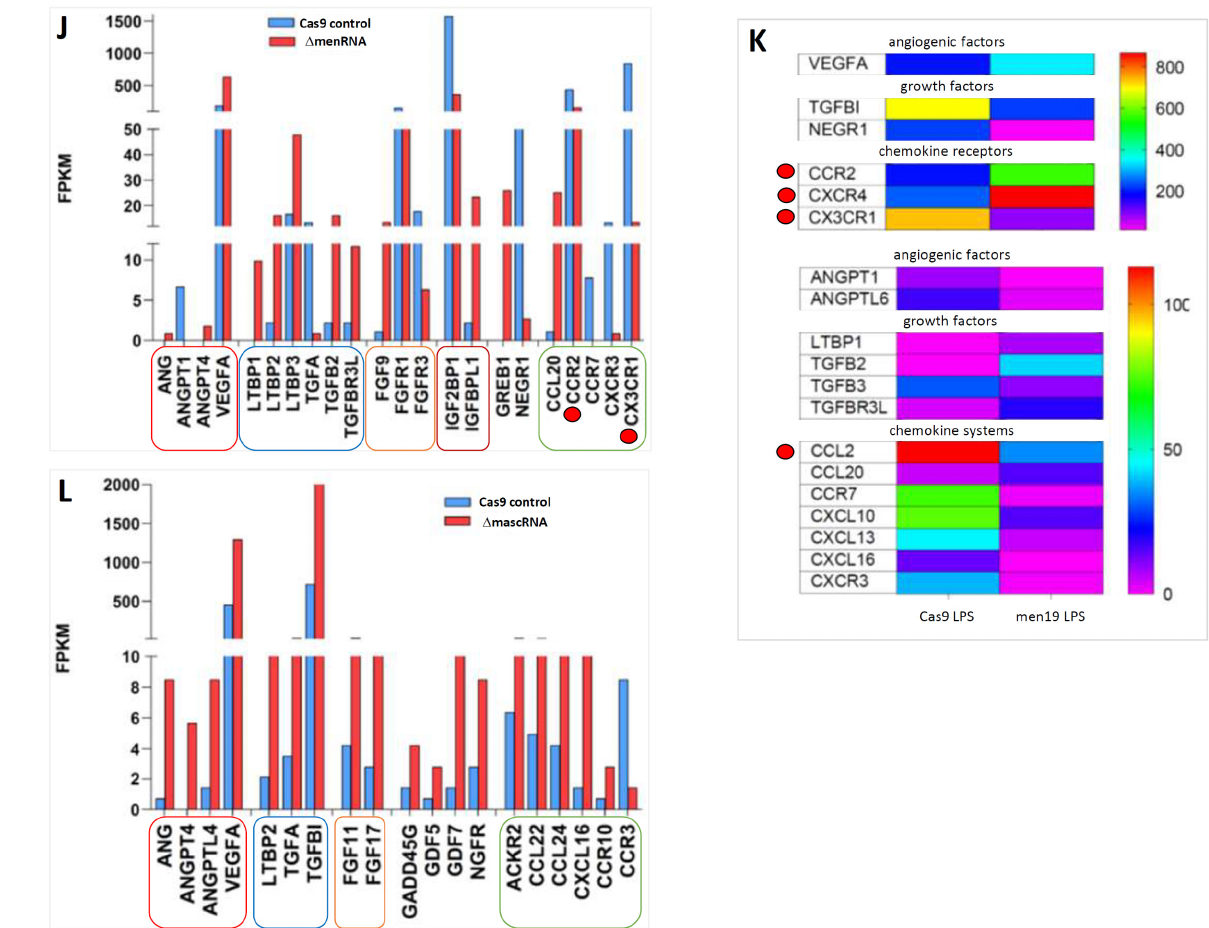
Figure 5. Impact of menRNA and mascRNA deletions upon monocyte-endothelium interactions and angiogenesis. Panels ( A – D ) (Endothelial cell interactions): At the cellular level, ∆ menRNA monocytes displayed an anomalous growth pattern with spontaneous cell cluster formation in liquid culture (panel ( A )). Despite this morphological anomaly, there was no significant difference in their cell proliferation kinetics compared to ∆ mascRNA and control monocytes (data not shown). ∆ menRNA cells showed defective endothelial adhesion under multiple flow conditions (panel ( B